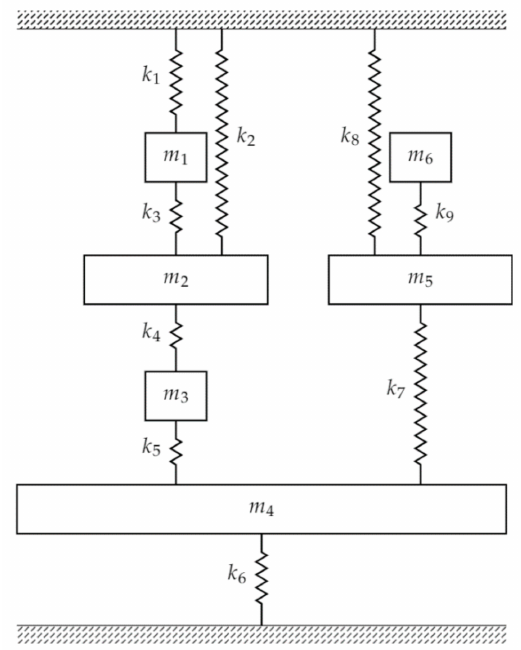
Figure 7. A sketch of the six-mass system.